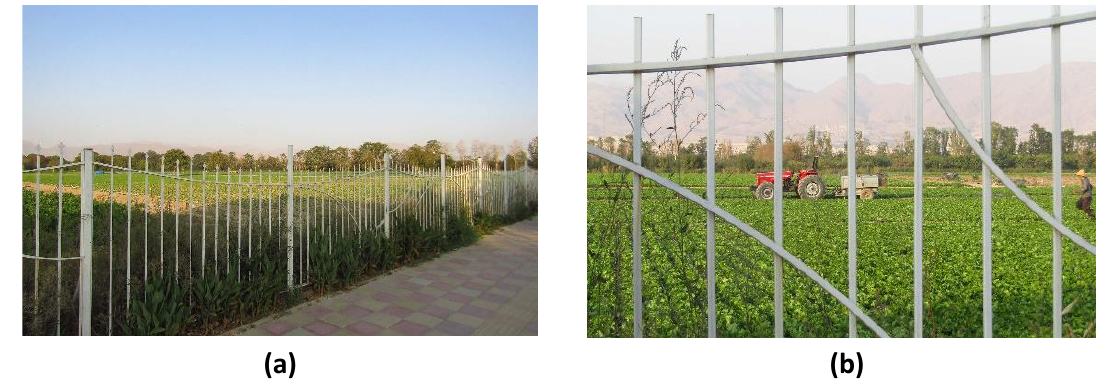
Fig. 9: (a) Clear visual view of Bagh-e-Sib; (b) Doing agricultural activities in Bagh-e-Sib